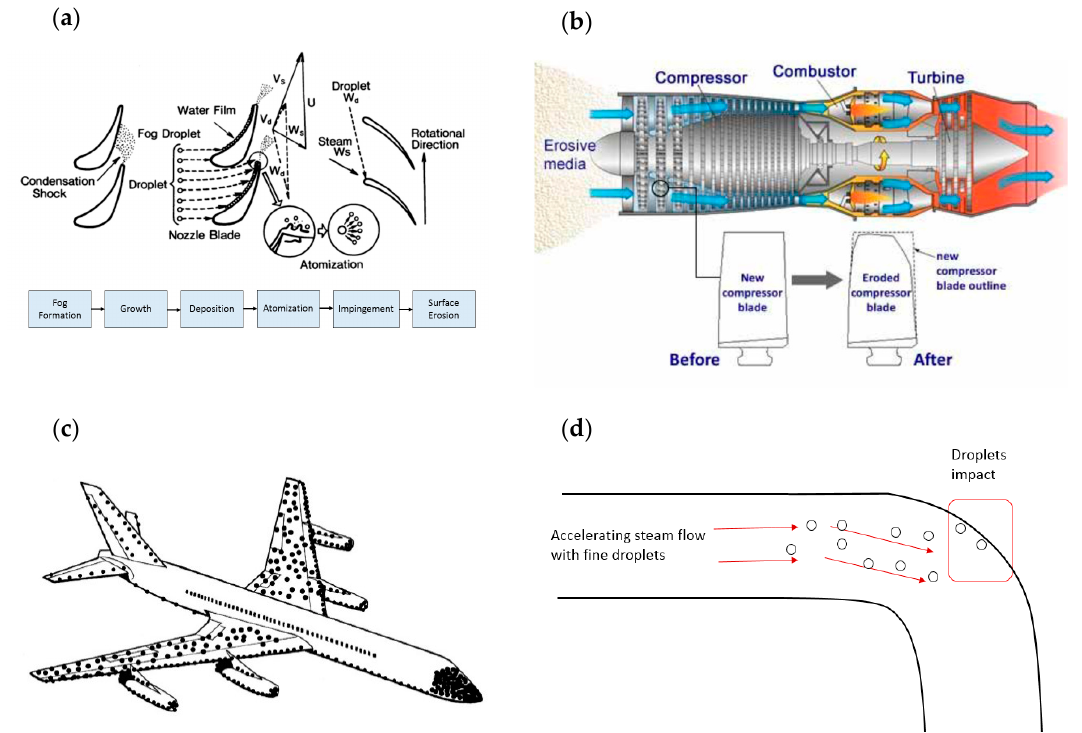
Figure 1. Examples of WDE (wet droplet erosion) occurrence; ( a ) blades of low-pressure stage in steam turbine [32], ( b ) compressor of gas turbine (courtesy of MDS Coatings Technologies Corp.), ( c ) parts of airplane, redrawn from [25], and ( d ) pipes of nuclear power plants [29].